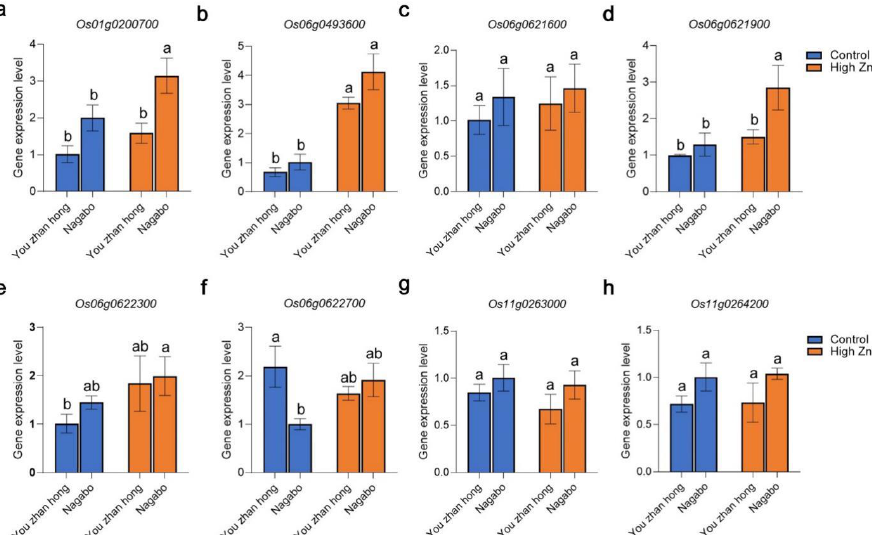
Figure 5. The gene expression of 8 candidate genes in representative varieties (the most sensitive variety in the present study, You zhan hong; the most tolerant variety in the present study, Nagabo) in control and high Zn conditions as measured by qRT-PCR. Error bars: S.D. The different letters indicate significant differences by one-way ANOVA analysis with Tukey’s HSD test ( p < 0.05, n = 3).